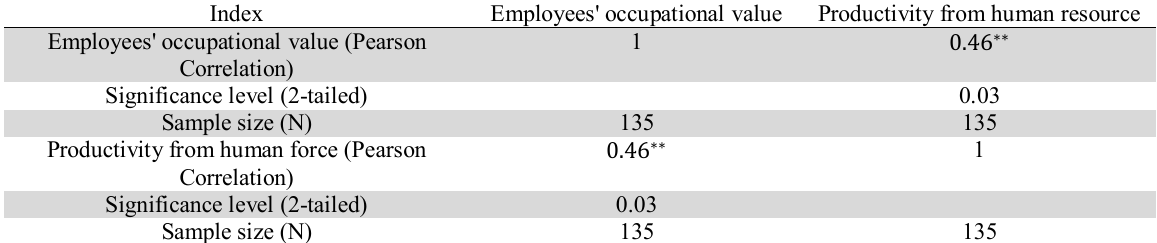
Result from Pearson's test about relationship between employees' occupational value and productivity from human